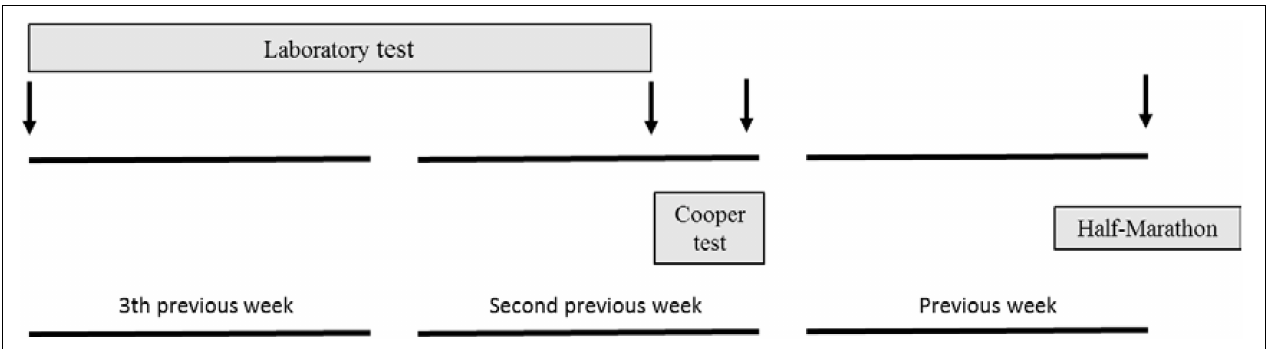
FIGURE 1 | Schedule of laboratory and Cooper tests and the